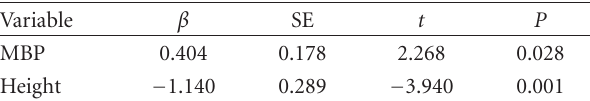
Table 8: Stepwise regression analysis for AI (diabetic patients). R 2 = 0 . 303, RMSE 16.58, F = 10 . 65, P < . 001. Variable β